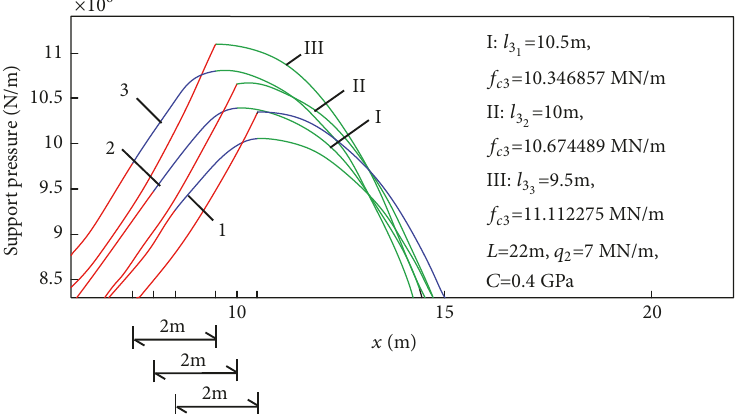
Figure 17: Enlarged drawings at peak part of coal seam support pressure for different softening area depths.